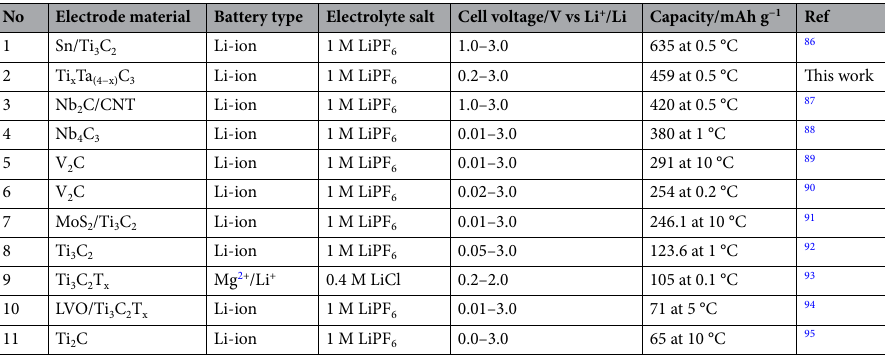
Table 1. Comparison of the bi-metallic Ti x Ta (4−x) C 3 MXene performance with reported MXene anodes.